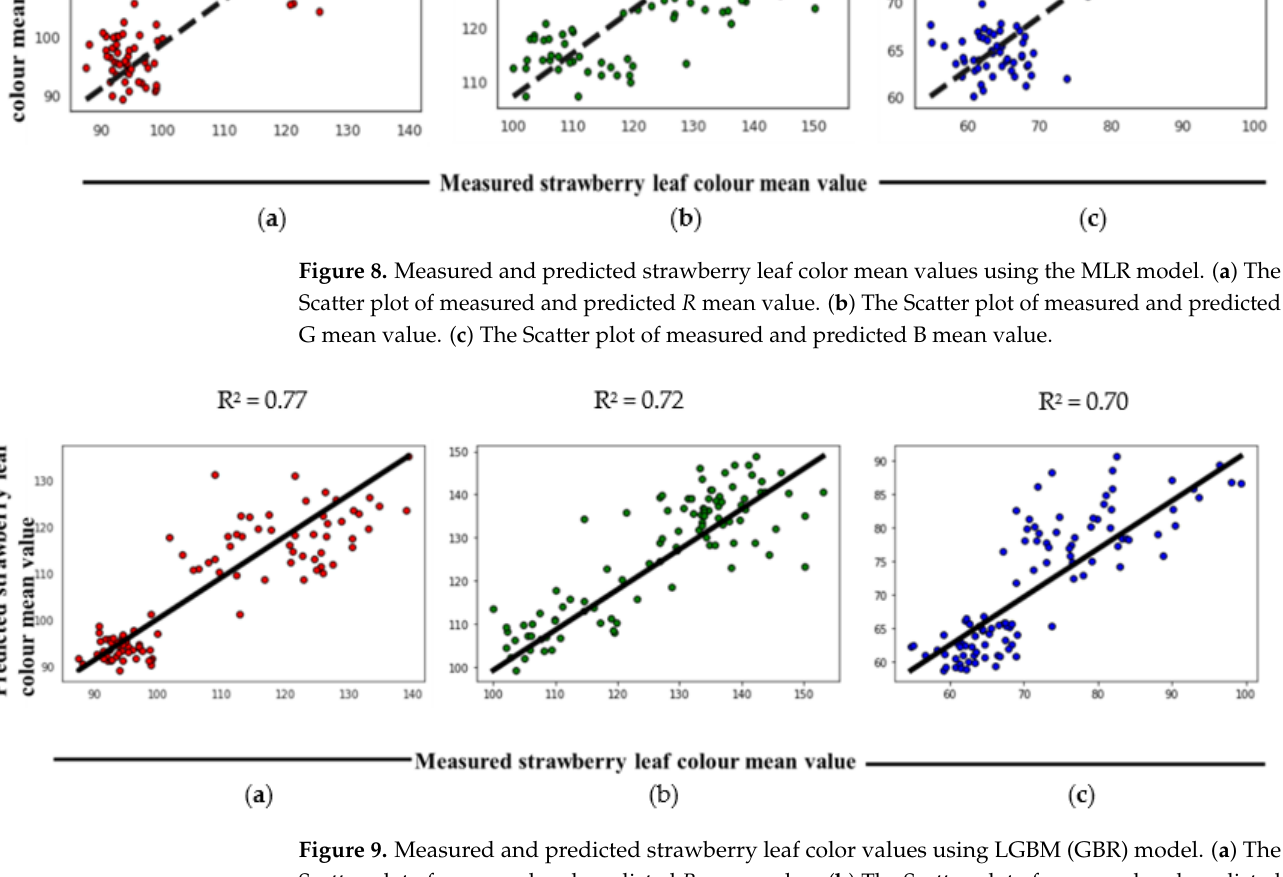
Figure 8. Measured and predicted strawberry leaf color mean values using the MLR model. ( a ) The Scatter plot of measured and predicted R mean value. ( b ) The Scatter plot of measured and predicted G mean value. ( c ) The Scatter plot of measured and predicted B mean value.